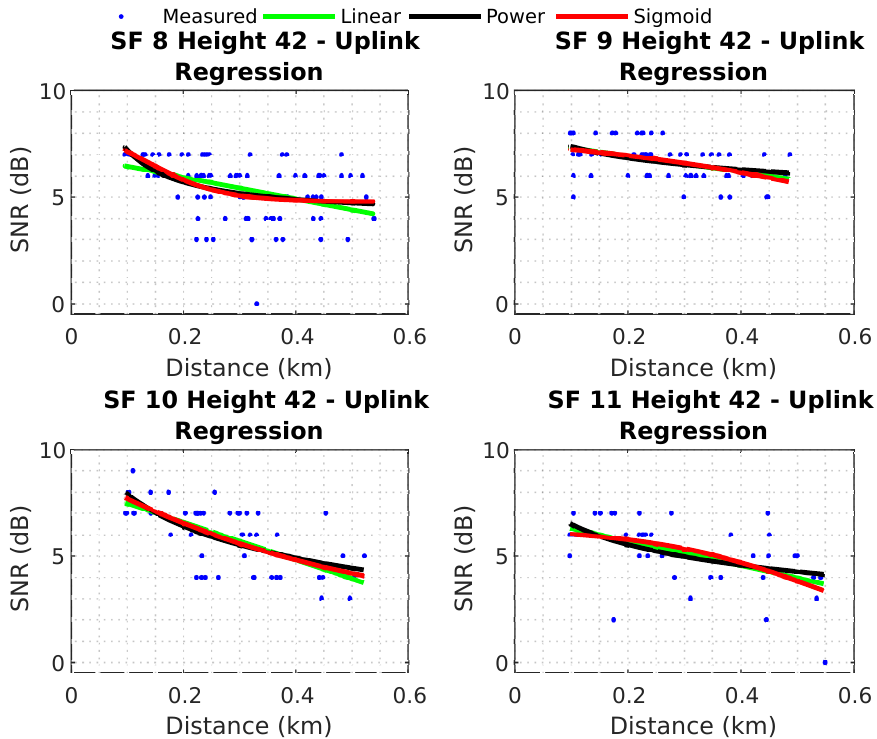
Figure 14. Baseline models uplink.